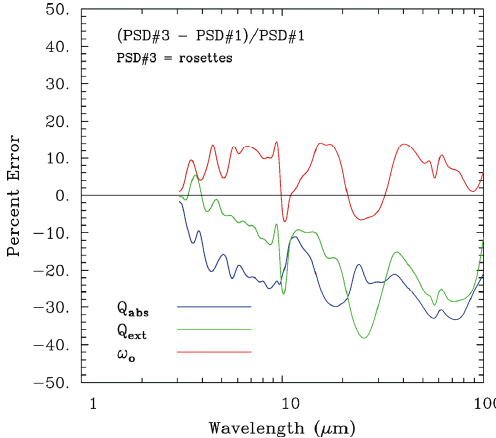
Figure 9. Wavelength dependence of optical property errors for PSD #3 in Fig. 4 (red curve), relative to the measured PSD (PSD #1). PSD #3 contains only bullet rosettes.